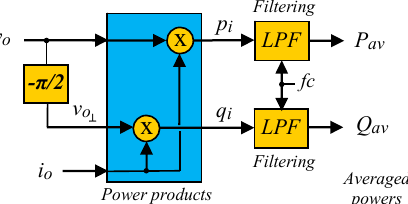
Figure 5. Block diagram of conventional P-Q power calculation providing the averaged powers P av and Q av .